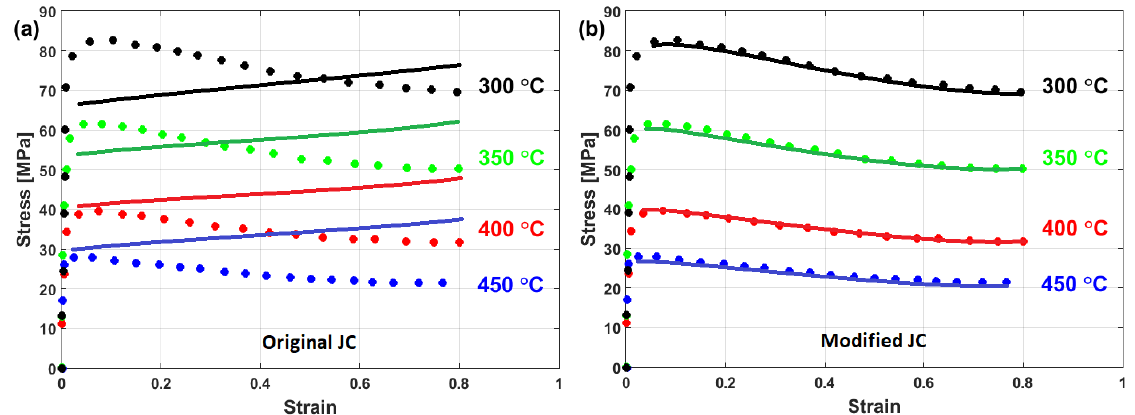
Figure 43. Comparison between experimental stresses (markers) and predicted stresses (solid lines) for A356 alloy obtained by ( a ) original JC and ( b ) modified JC that was presented by Niu et al. [90].